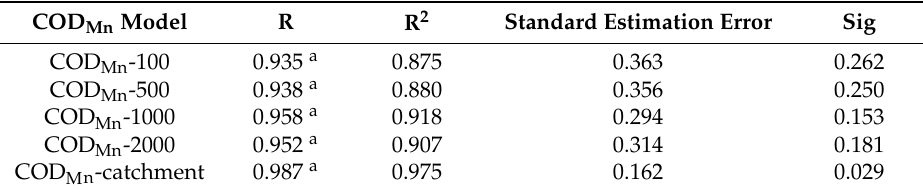
Table 8. The linear model general situation of COD Mn .